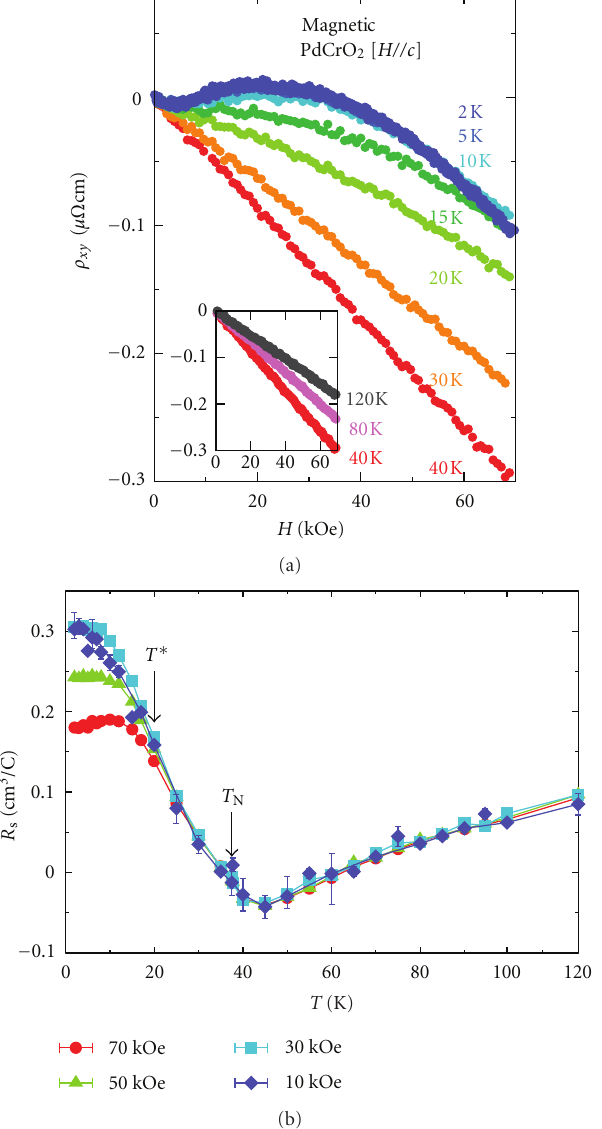
Figure 12: (a) A plot of ρ xy as a function of H at various tem- peratures measured using single crystals of PdCrO 2 . A departure from linear behaviour is seen below T = 30 K , followed by the development of a broad hump between 10–40 kOe. (b) Calculation of the anomalous Hall coe ffi cient, R S , using (4) at various fields. A clear field dependency is observed below T ∗ . Figures are taken from